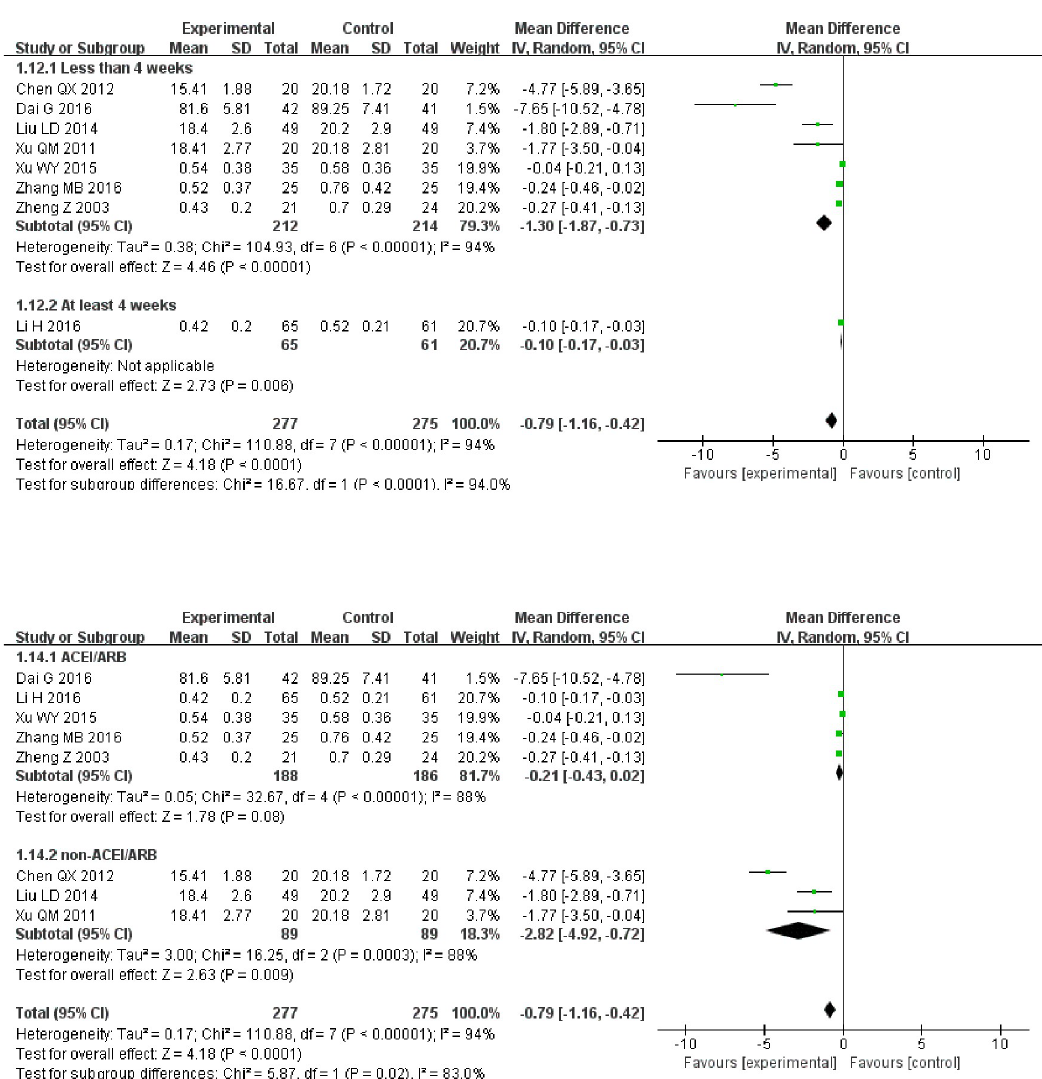
Fig 4. A. Forest plot of 24 h urinary protein subgroup analysis, based on treatment duration. B. Forest plot of 24 h urinary protein subgroup analysis based on treatment